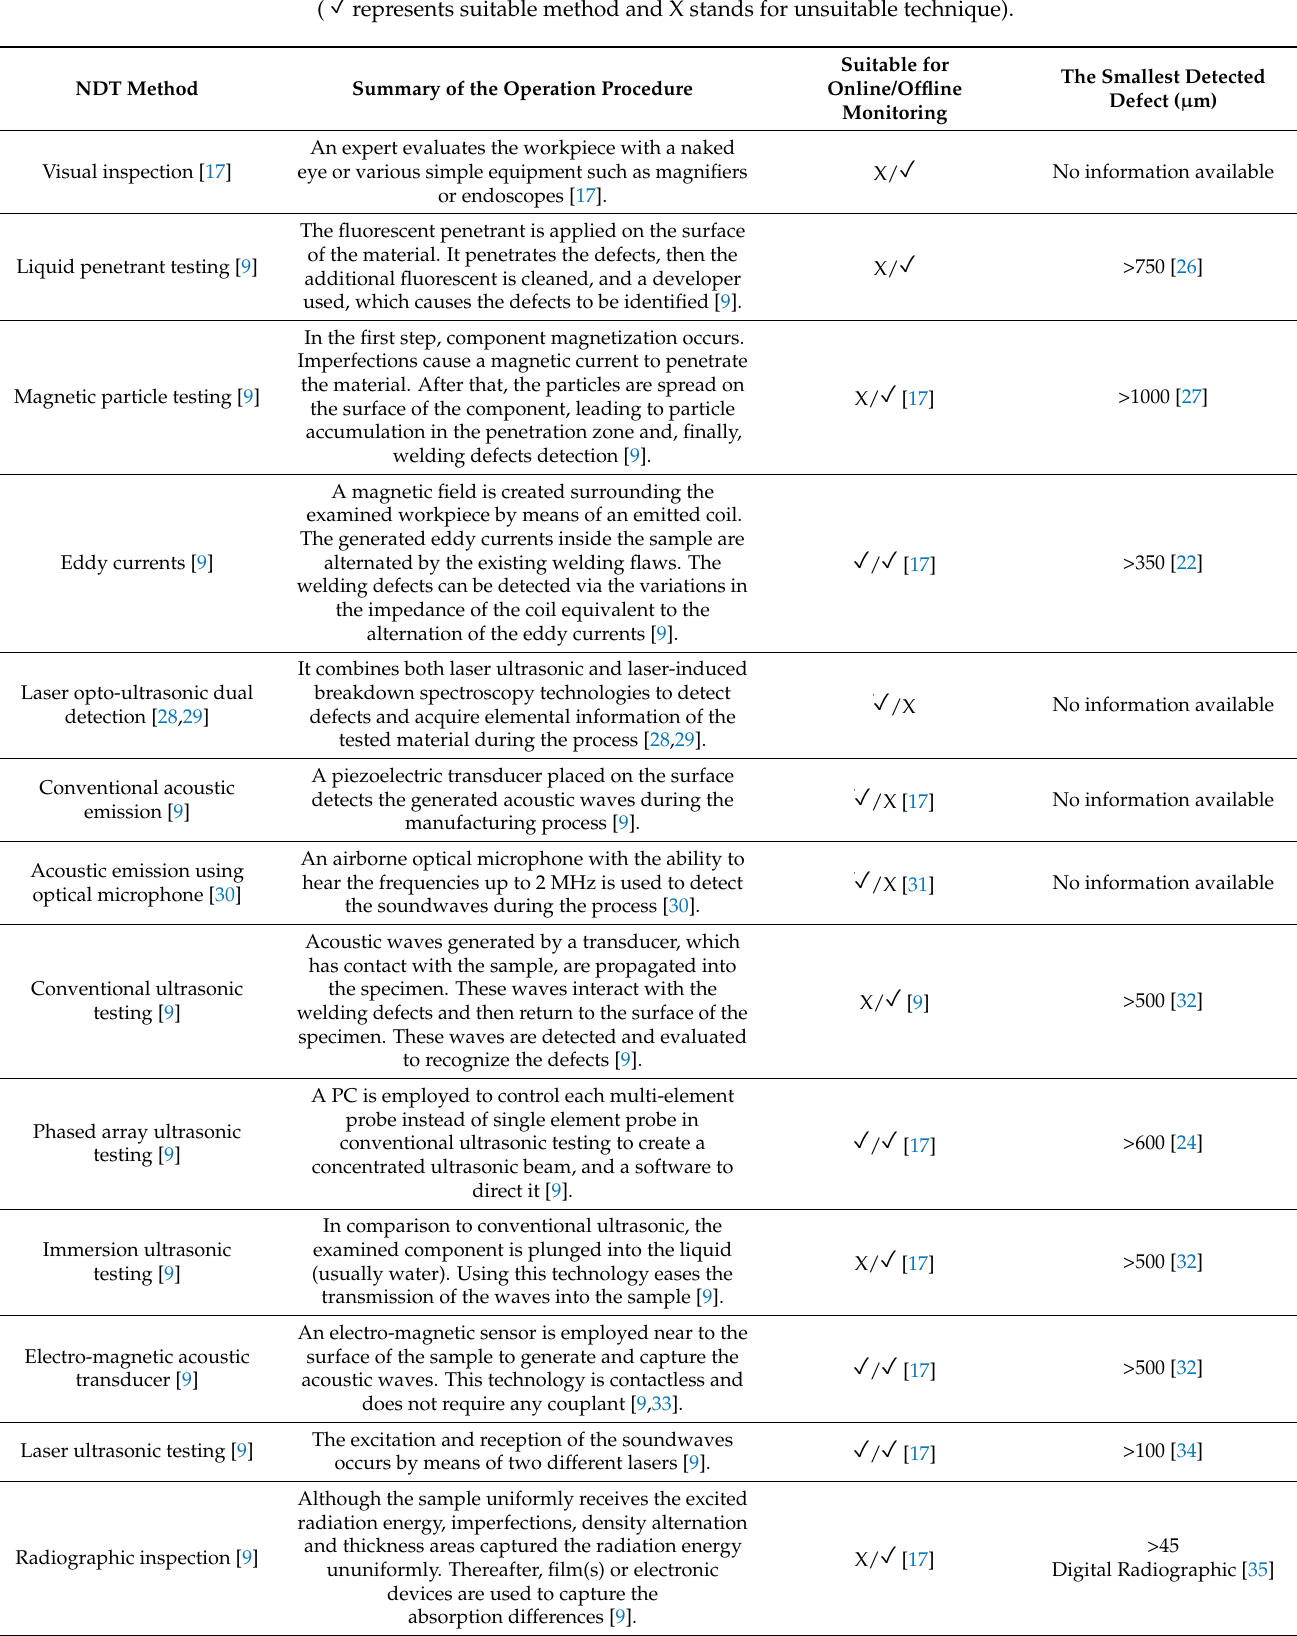
Table 1. A review of NDT methods and the smallest detected defect for WAAM and fusion